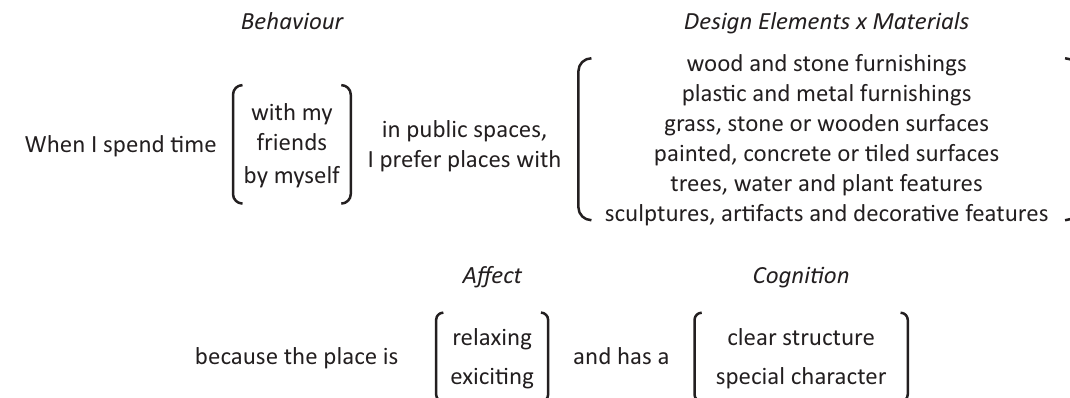
Figure 1. The mapping sentence used in the survey of stationary